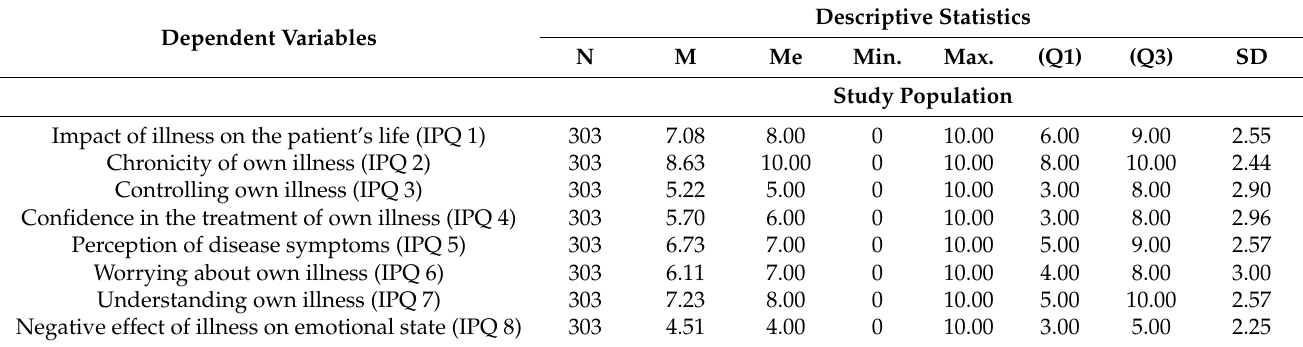
Table 2. Descriptive statistics regarding the perception of own illness as measured by the